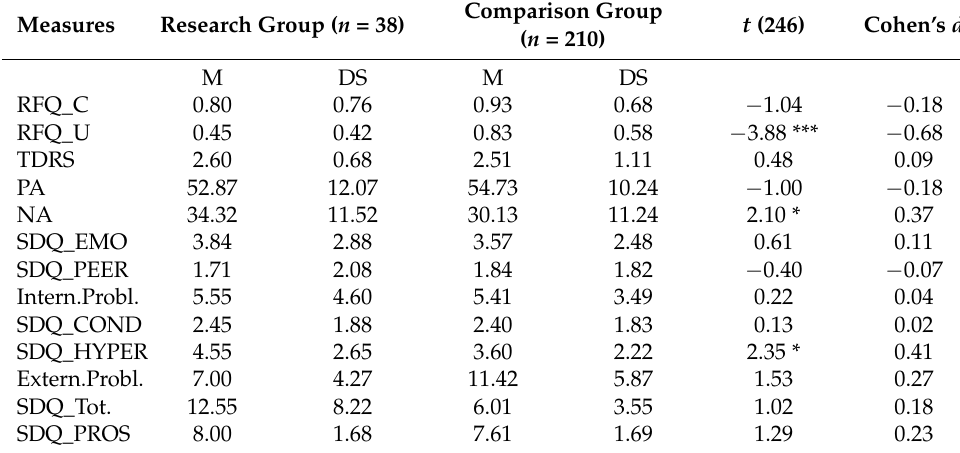
Table 6. Descriptive statistics of study variables for children of research and comparison group with t -test results and Cohen’s d